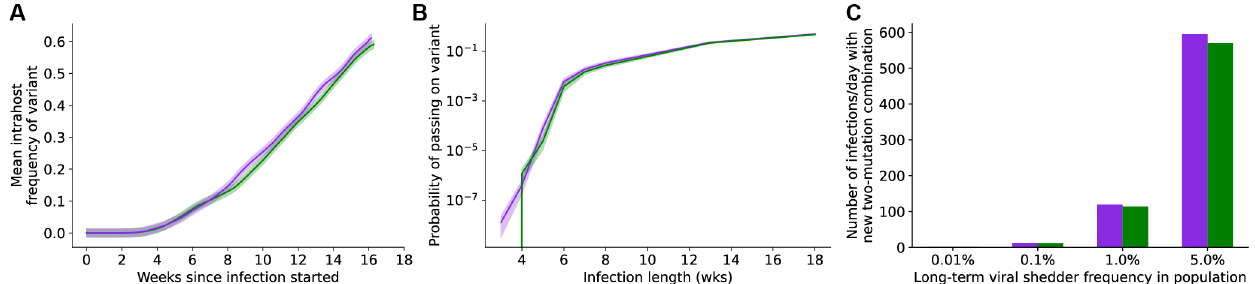
Figure 6. Vaccination does not decrease the rate of generation of new variants with multiple mutations within hosts with prolonged SARS-CoV-2 infections. ( A ) Frequencies of an advantageous viral variant with two new point mutations (final variant has a 50% fitness benefit over the wild-type) within a vaccinated (purple) or unvaccinated (green) infected individual over a prolonged SARS-CoV-2 infection. ( B ) Probabilities of generating and transmitting an advantageous viral variant with two new point mutations (final variant has a 50% fitness benefit over the wild-type) within a vaccinated (purple) or unvaccinated (green) infected individual over a prolonged SARS-CoV-2 infection. In ( A , B ), shaded regions represent 95% binomial confidence intervals. ( C ) Population-level rates of generating new two-mutant SARS-CoV-2 variants with a 50% fitness benefit assuming different frequencies of long-term SARS-CoV-2 infections in the population. All infected individuals were assumed to either be vaccinated (purple) or unvaccinated (green).